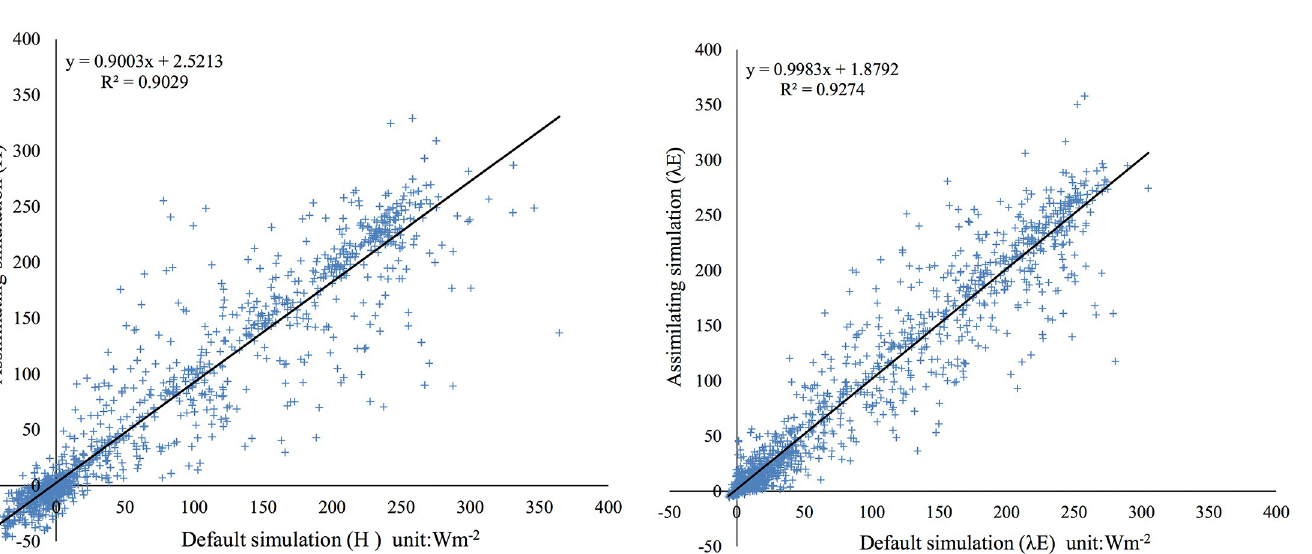
PLOS ONE | https://doi.org/10.1371/journal.pone.0226373 December16,